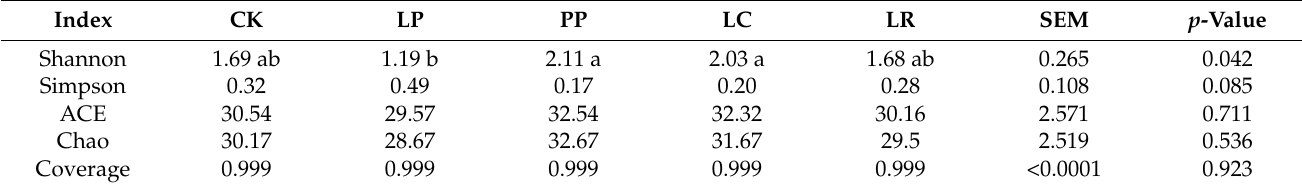
Table 4. Estimation of bacterial community diversity of the oat